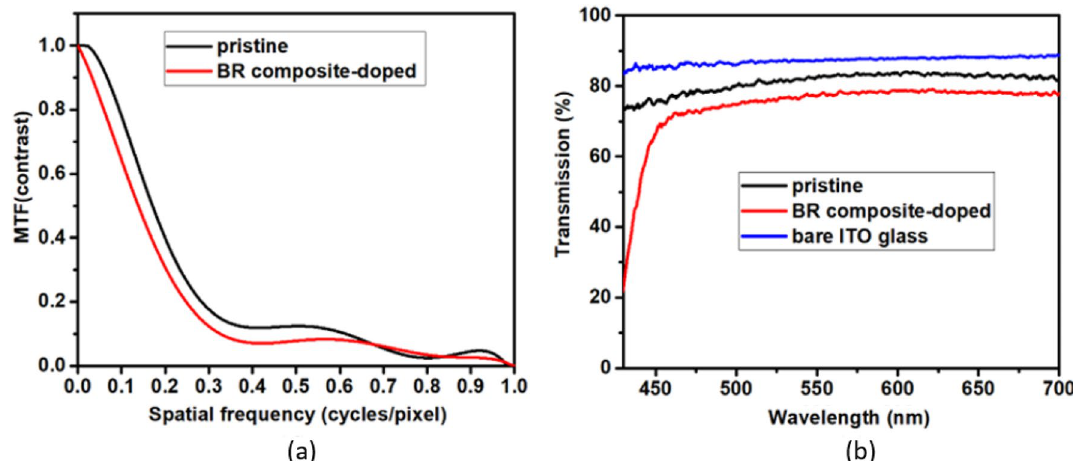
Figure 7. ( a ) MTFs of the images created through the pristine and BR composite-doped HLC lenses. ( e ) Transmission spectra of the bare ITO glass and the pristine and BR composite-doped HLC